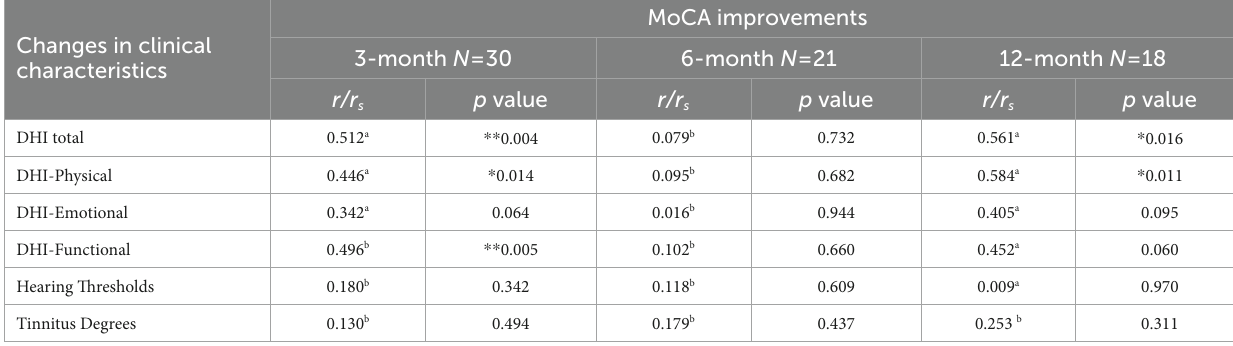
TABLE 6 Correlation of improvements in MoCA scores and clinical